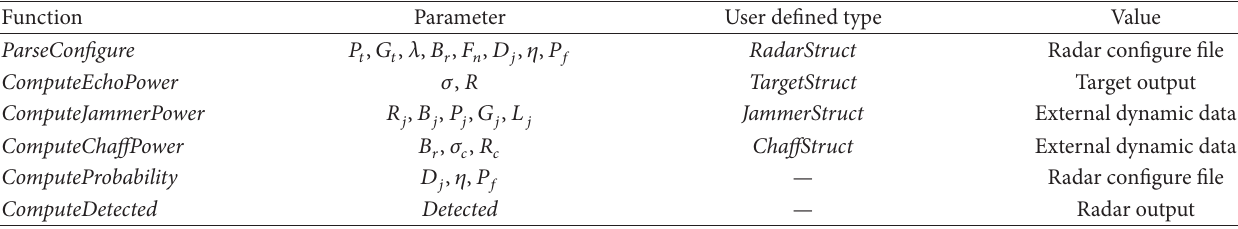
Table 2: Functions of radar computational module.